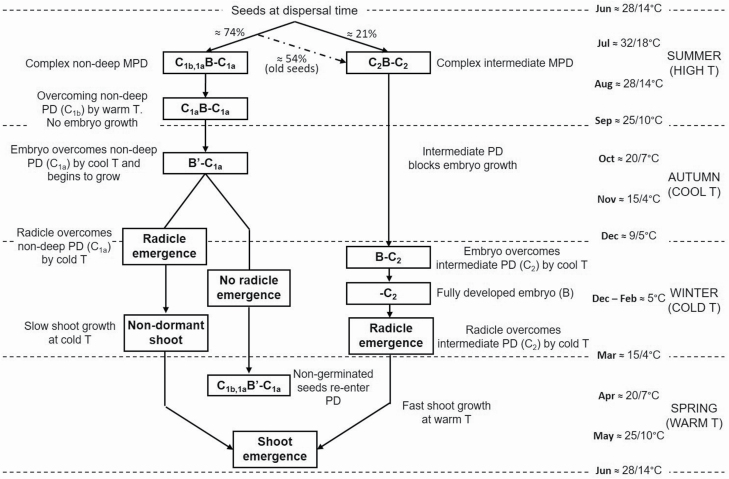
Conceptual model of dormancy break in seeds of N. yepesii. Temperature (T), underdeveloped embryo (B), PD (C), non-deep PD (subscript 1), intermediate PD (subscript 2), warm stratification requirement (subscript b), cold stratification requirement (subscript a). Some seeds re-enter MPD, where B′ indicates embryos have grown, but have not fully developed.